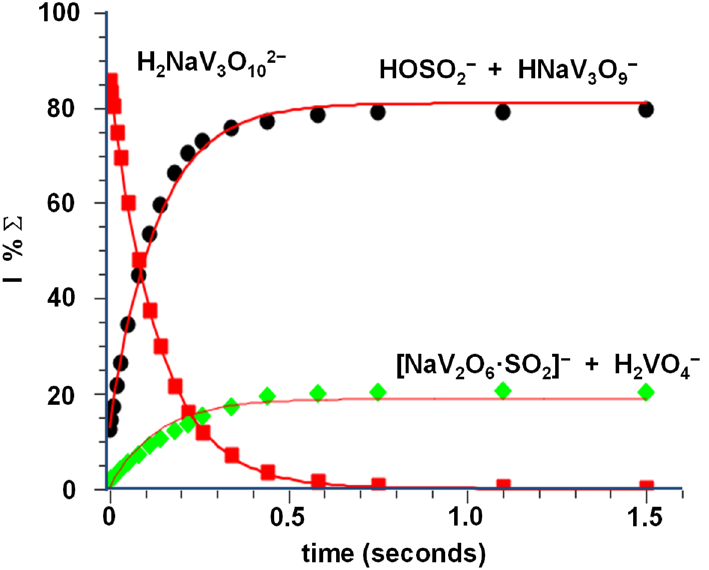
Figure 4. Kinetic plot and best fit lines of the reaction of thermal H 2 NaV 3 O 102 − ions with SO 2 , P(SO 2 ) = 2.1 × 10 − 7 torr, R 2 (H 2 NaV 3 O 102 − ) = 0.9998, R 2 (H 2 VO 4 − + NaV 2 O 6 · SO 2 − ) = 0.9652, R 2 (HOSO 2 − + HNaV 3 O 9 − ) = 0.9964.